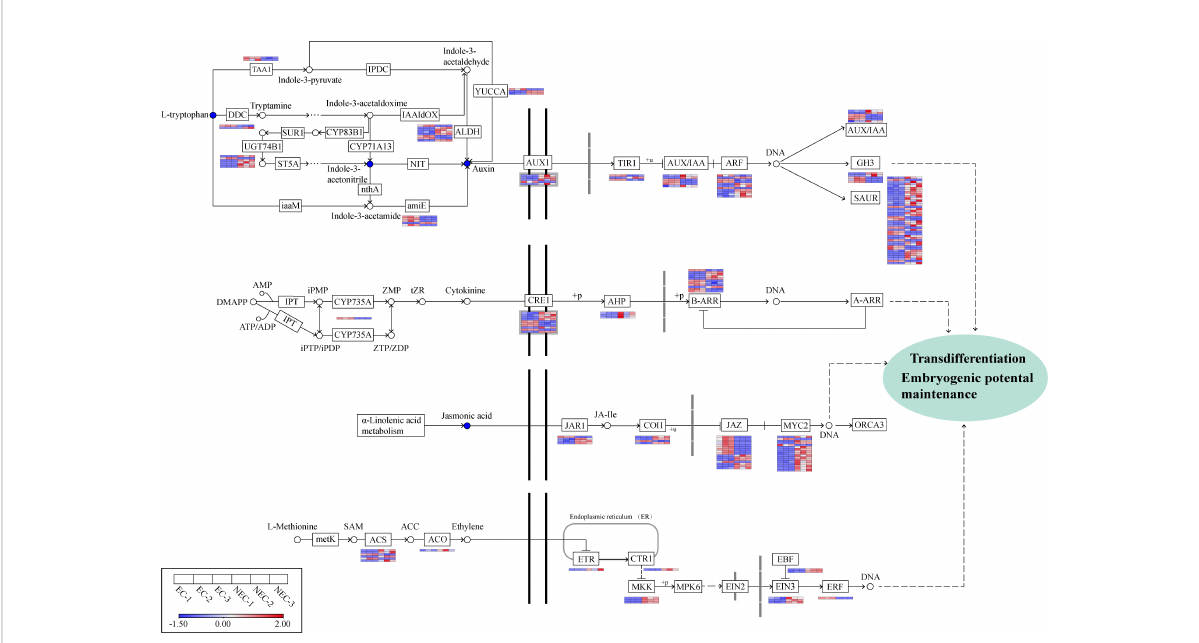
FIGURE 7 Analysis of DEGs involved in plant hormone synthesis and signal transduction pathways. Gene expression levels based on FPKM values are indicated at the side of each step. Red and blue blocks represent upregulation and downregulation of gene expression, respectively. Enzyme abbreviations involved in plant hormone synthesis: TAA1, L-tryptophan — pyruvate aminotransferase; DDC, L-tryptophan decarboxylase; UGT74B1, N-hydroxythioamide S-beta-glucosyltransferase; ALDH, aldehyde dehydrogenase; amiE, amidase; YUCCA,